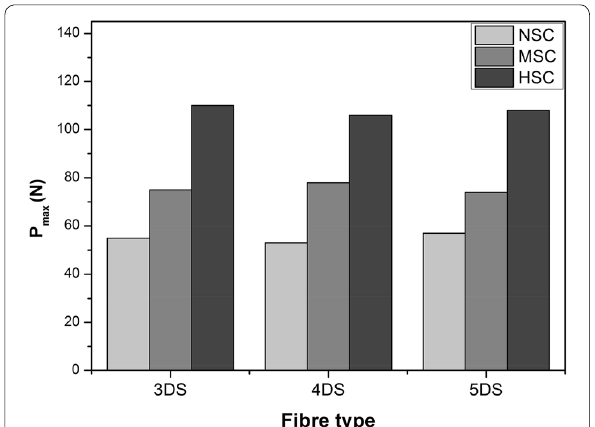
Fig. 5 Maximum pull-out load (P max ) of 3DS, 4DS and 5DS straight